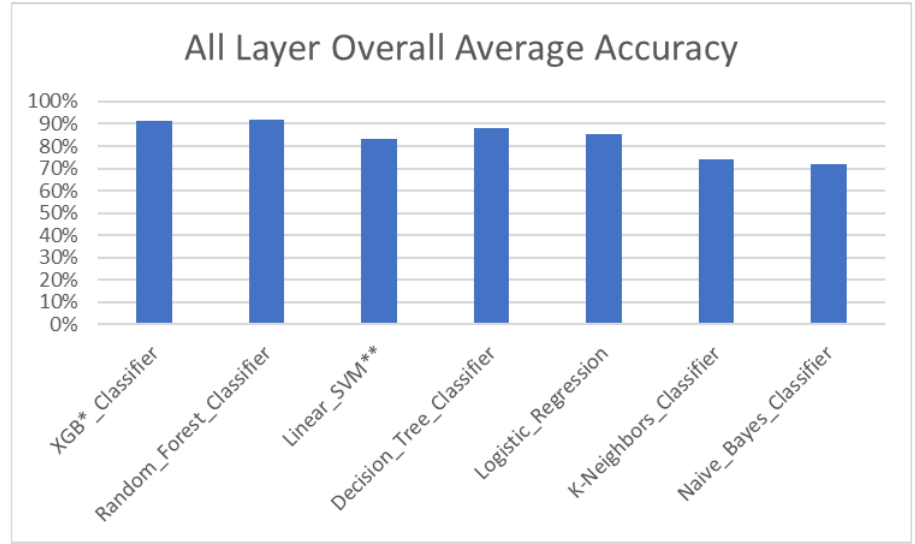
Figure 8. Overall accuracy of the ML model. * XGB — eXtreme Gradient Boosting. ** SVM — Support Vector Machine.